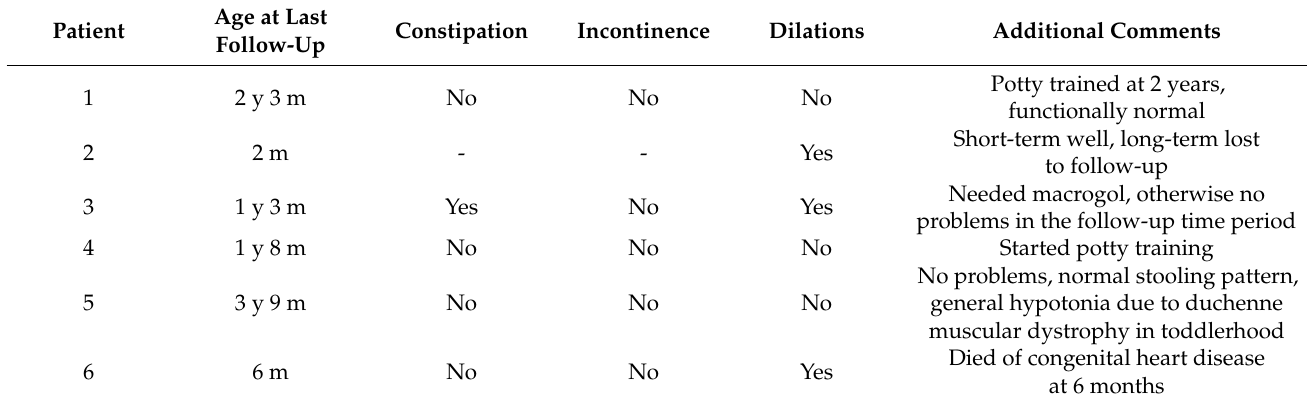
Table 3. Postoperative data and outcomes (y—years,